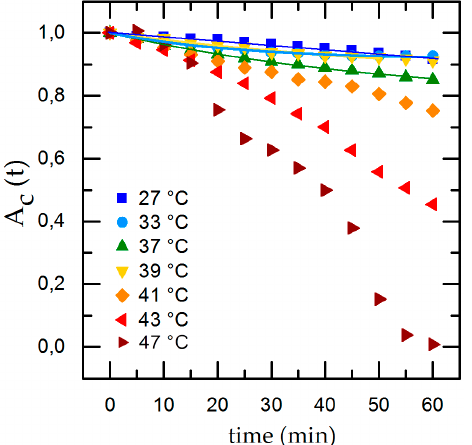
Figure 4. Temperature-dependent cell detachment with time and exponential fit for detachment rate in the physiological range of 27 °C ≤ T ≤ 39 °C.